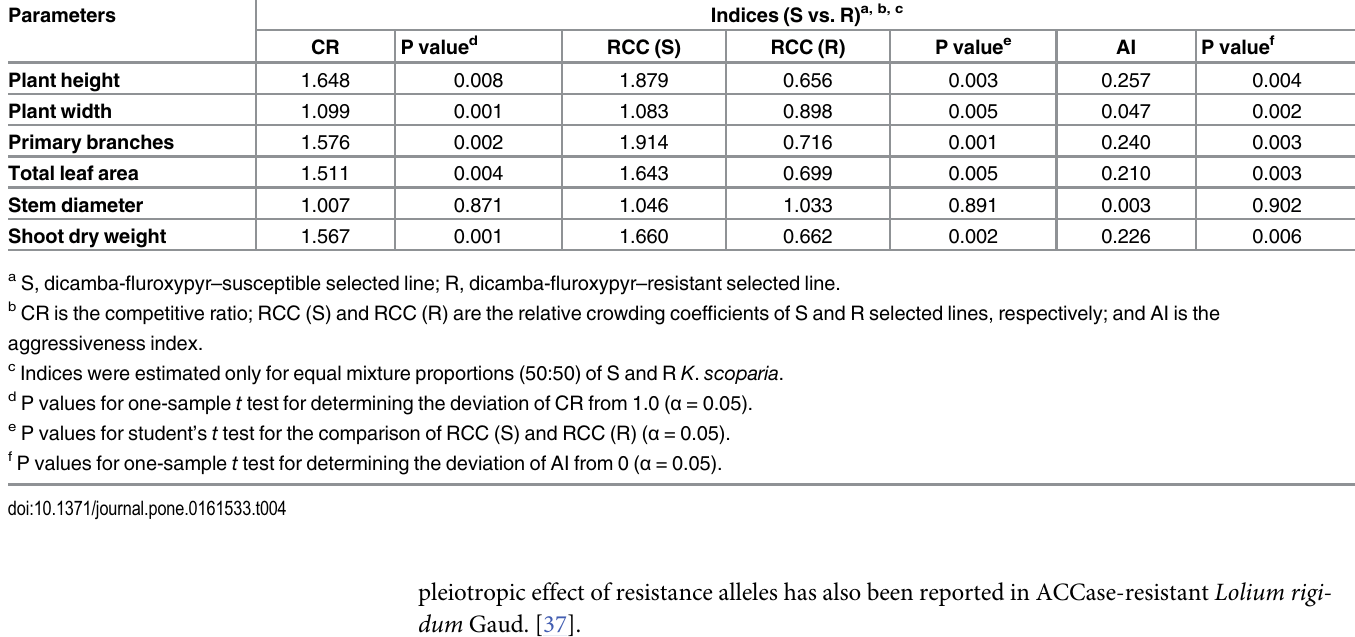
Table 4. Estimated indices for growth parameters of dicamba-fluroxypyr – susceptible (S) and – resistant (R) K . scoparia in the replacement series experiments averaged over experimental